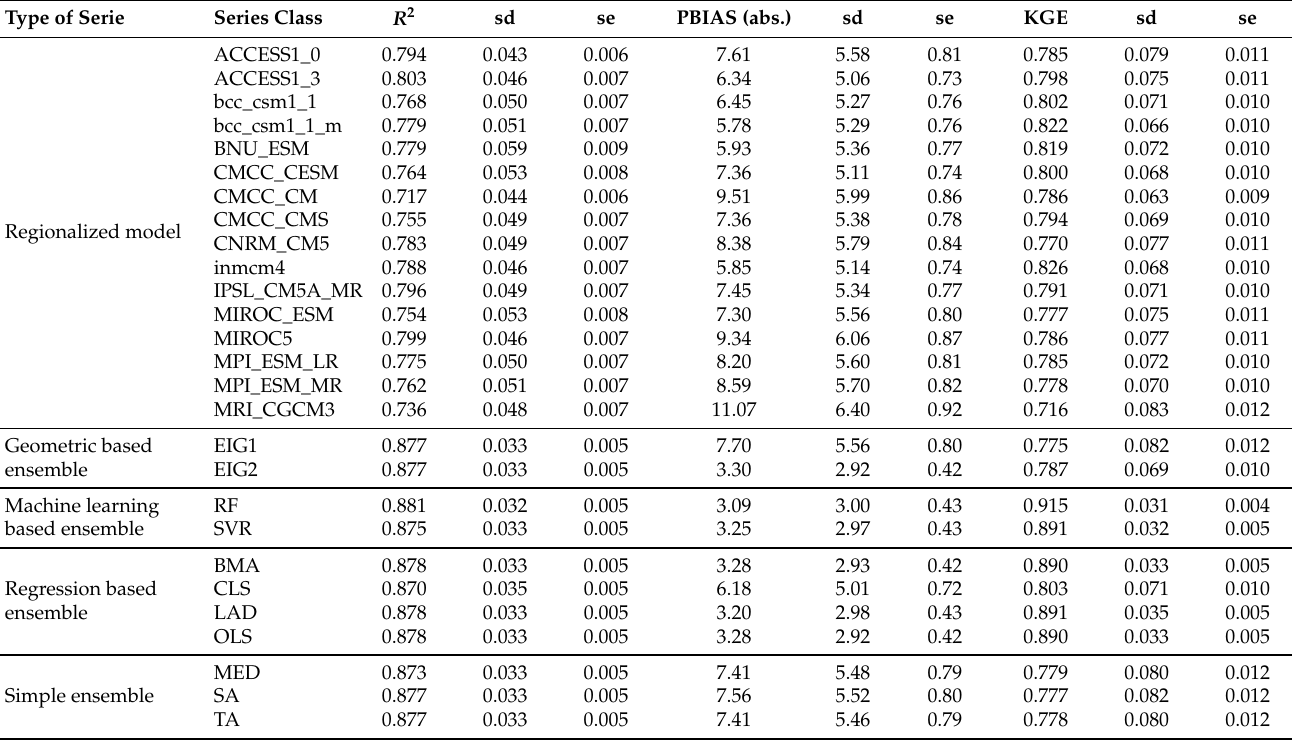
Table A2. Goodness of fit statistics in validation for the different series. N = 1296 observations ( n k = 48 weather stations by class).